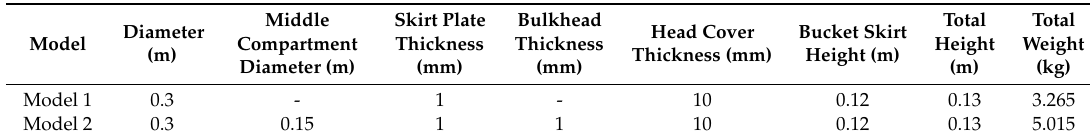
Table 1. Dimensions of the test model.